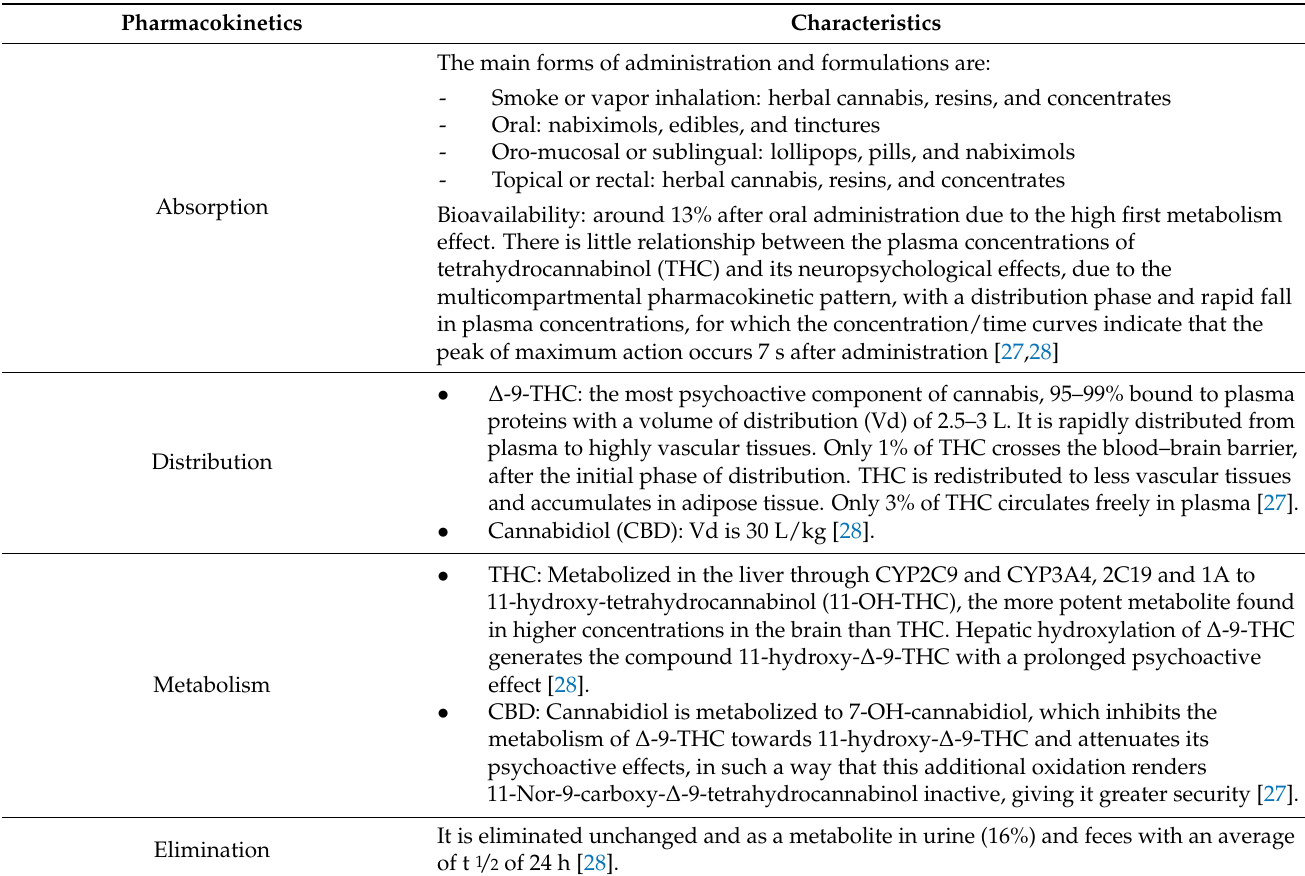
Table 1. Key aspects of the pharmacokinetics of medicinal cannabis [26].